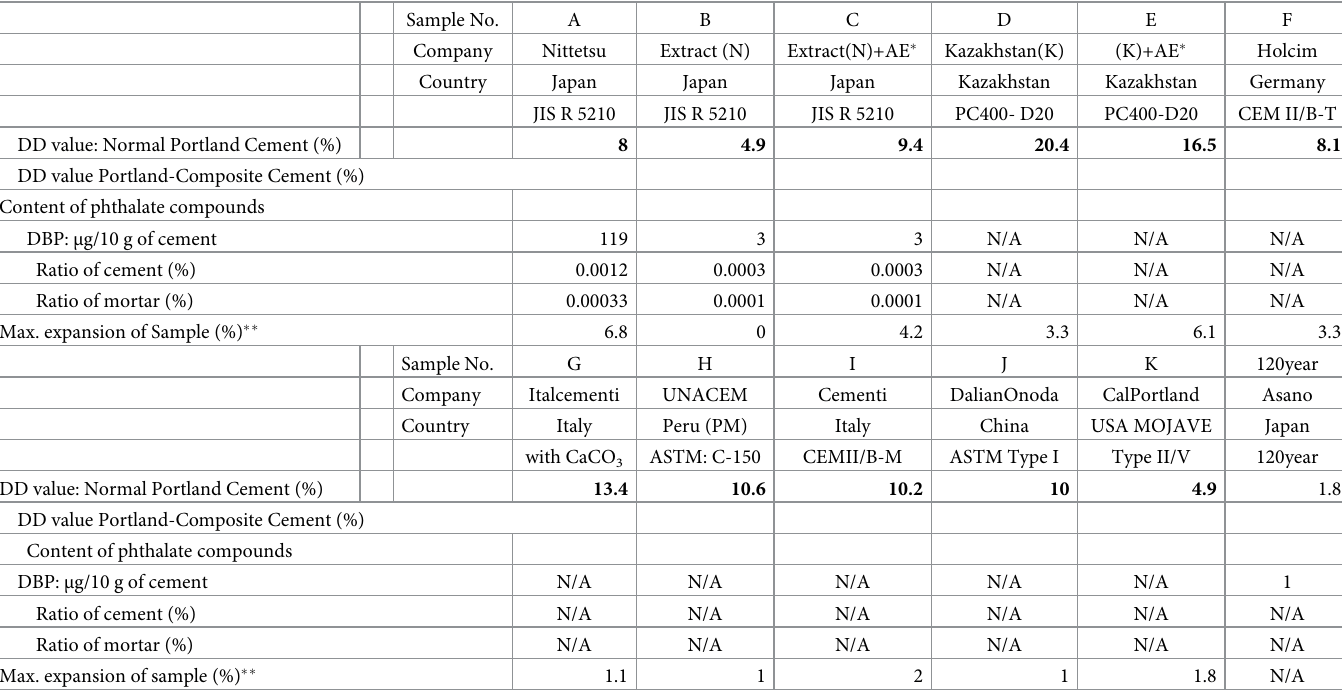
Table 1. The degree of deterioration (DD value: %) in mortar samples, content of DBP in cement and /or mortar, and maximum expansion of samples (%). Sample